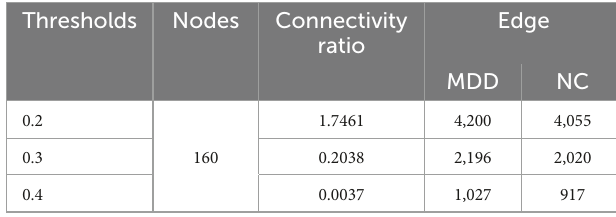
TABLE 2 The optimal parameters of each method.